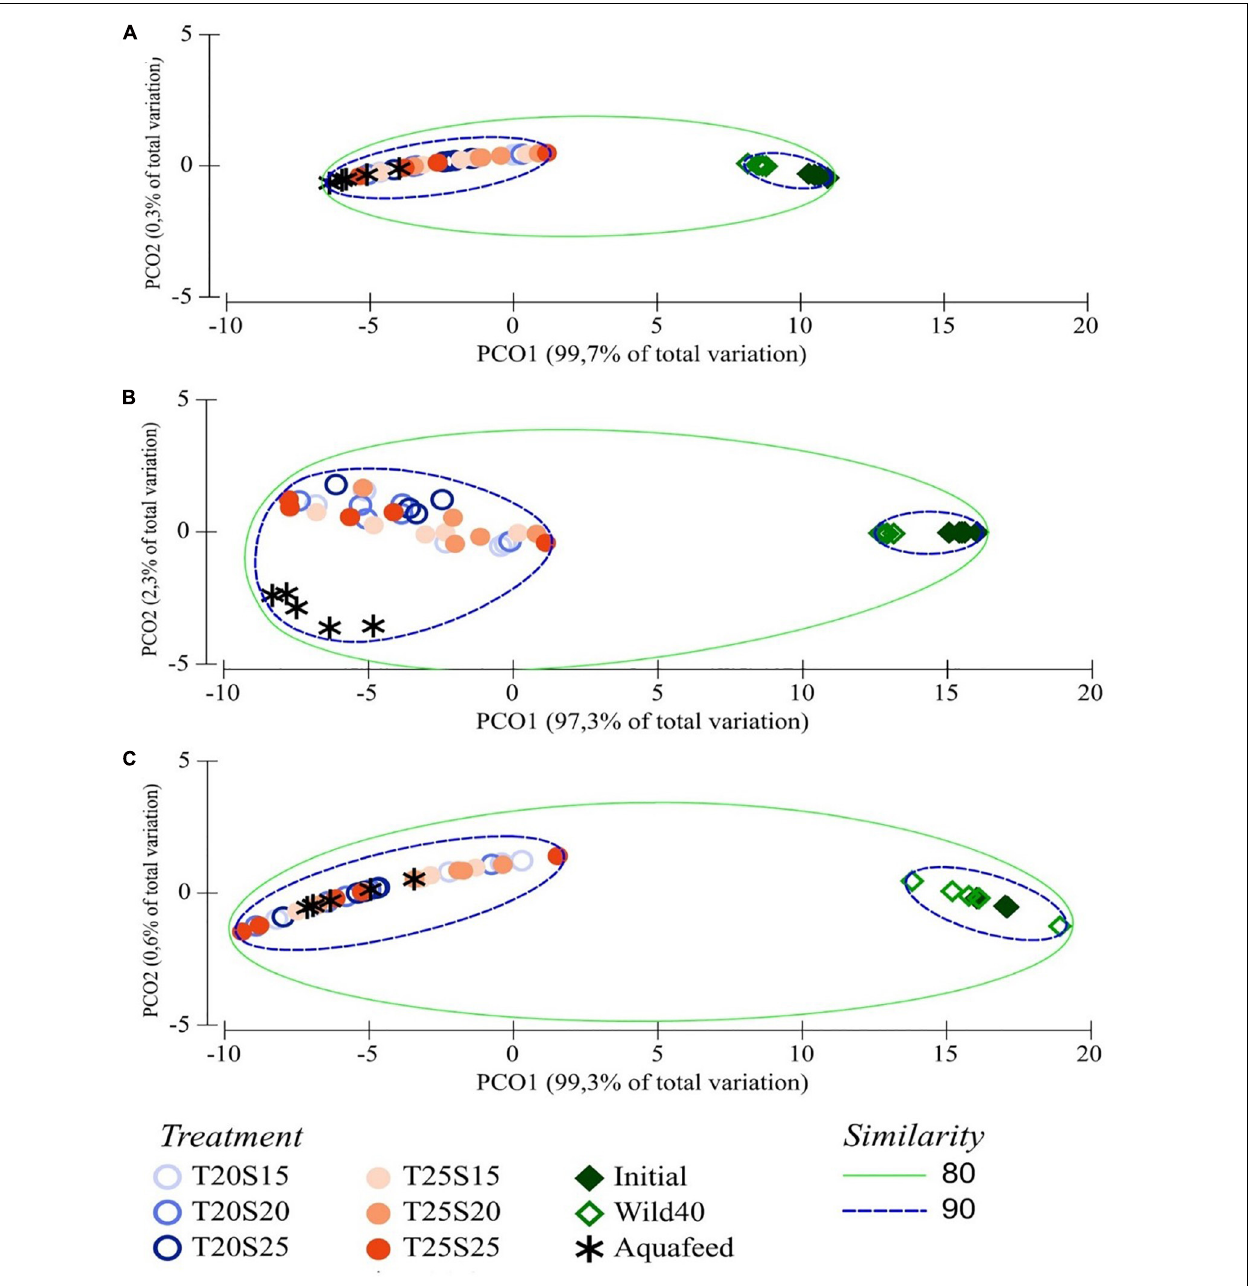
FIGURE 5 | Principal coordinates analysis (PCO) of total fatty acids (FA) (A) , sum of FA classes (SFA, MUFA, PUFA, and HUFA) (B) , sum of n -3 and n -6 FA (C) of Hediste diversicolor fed a commercial aquafeed for 40 days under different combinations of water temperature (T—20 and 25 ◦ C) and salinity (S—15, 20, and 25) contrasted with that wild conspecifics initially stocked (Initial) and conspecifics collected on the same date (Wild40). Average values ( ± SD) ( n = 5). Green and blue lines define the levels of similarity between samples. PUFA are defined as all FA with 2 or 3 double bonds and HUFA as all FA with ≥ 4 double